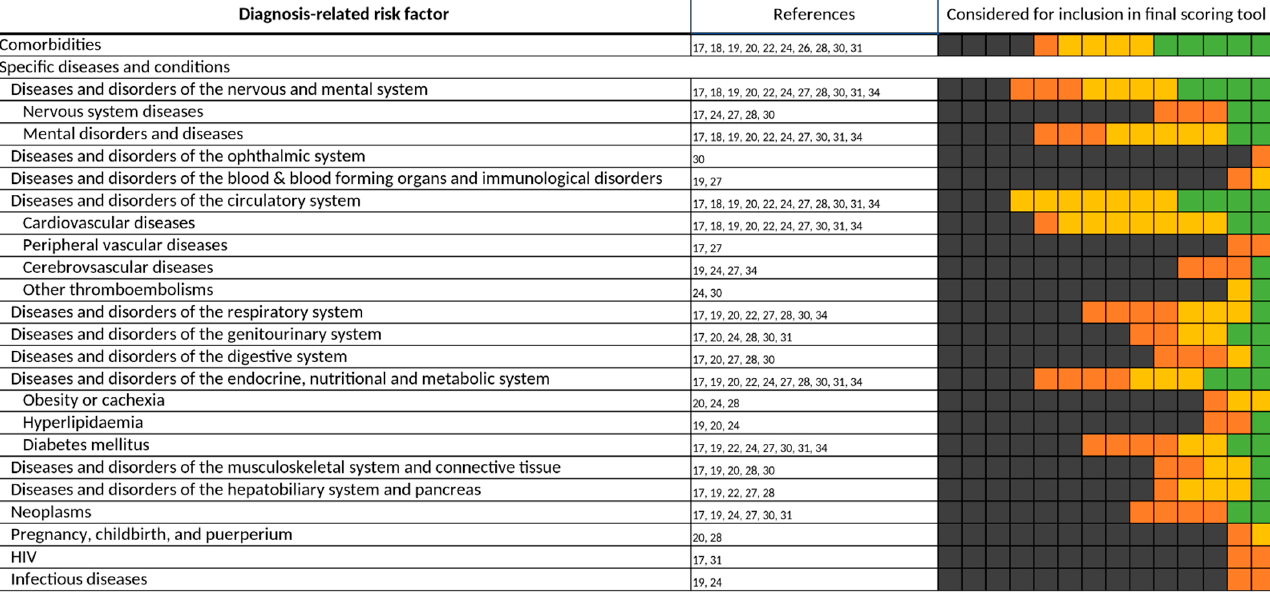
Figure 7. Diagnosis-related risk factors. Specific diseases and conditions were assigned according to their respective Major Diagnostic Categories (MDC). Each of the 14 boxes represents one of the included studies. The color of the boxes portrays whether a risk factor was not investigated in a study (gray), was investigated (orange), was significant in a first statistical analysis or based on expert consensus and therefore tested for inclusion in a final scoring tool (yellow), or whether a risk factor was included in a final scoring tool (green). The “citations”-column lists each study that at least investigated the respective risk factor.